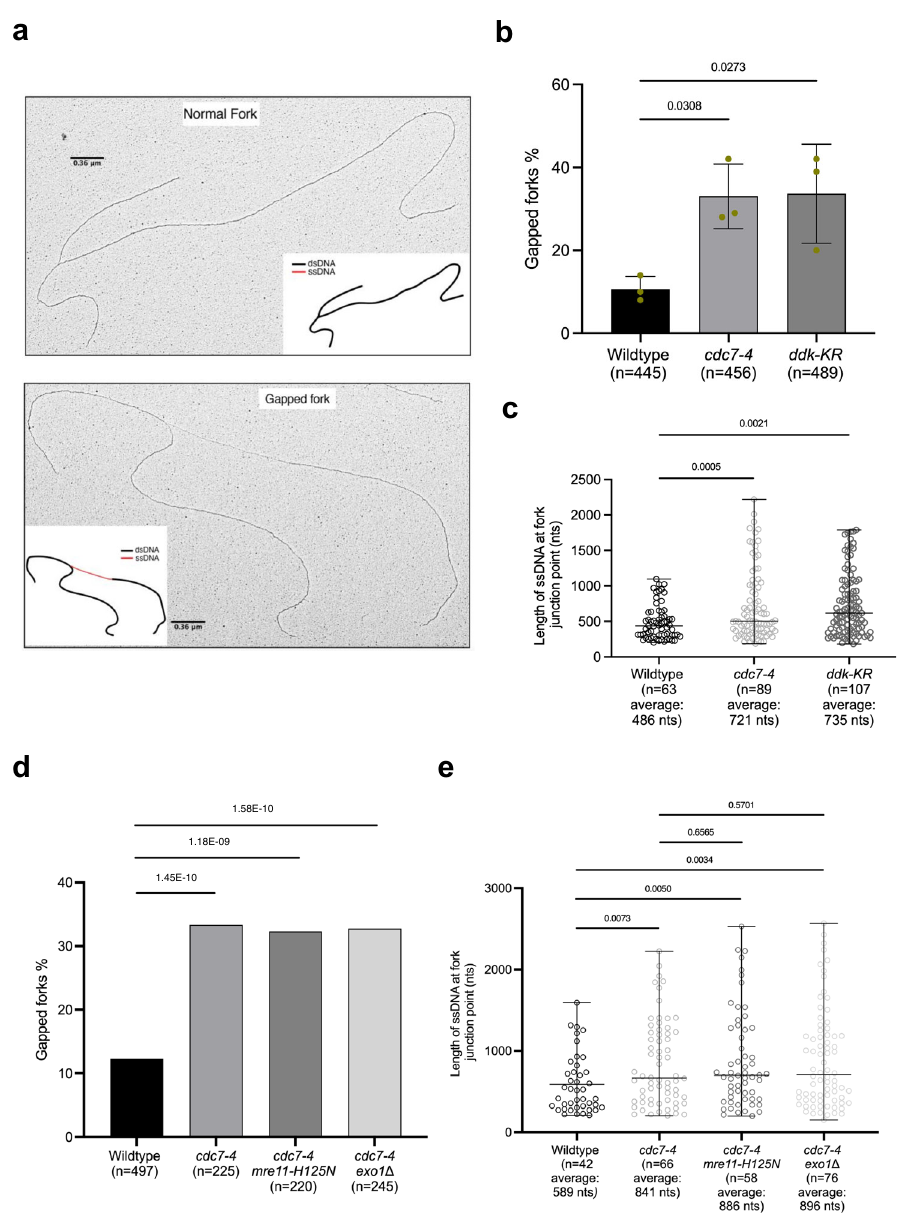
Fig. 3 SUMOylated DDK kinase prevents replication fork uncoupling. a Examples of normal and gapped forks visualized by Transmission electron microscopy (TEM) analysis along with schematic representations of DNA molecules with dsDNA (black) and ssDNA (red). Scale bars (black) of 360 nm calculated for dsDNA are reported. b TEM analysis of replication intermediates. Exponential cultures were arrested in G1 phase and released into S-phase in medium containing 0.033% MMS at 28 °C for 60 min. Histogram reports the percentages of gapped replication forks, from three independent experiments. The gapped forks category contains a small fraction of broken forks, derived from the mechanical breakage of the long ssDNA stretches present at the branching point of the gapped forks. The total number of replication intermediates scored in the three experiments is indicated as ‘ n ’ . Error bars represent standard deviation of three independent experiments, the center of the bar represents the average value. P -values were calculated by ordinary one-way ANOVA test. c Scatter dot plot representing the distribution of lengths of ssDNA stretches at the branching points of forks of indicated cells. Values are derived from the analysis of the samples presented in b . Central line in the plot indicates the average length of ssDNA discontinuity (in nucleotides), the bars represent distribution range. P values were calculated by unpaired two-tailed Student ’ s t test. d TEM analysis of the DNA replication intermediates formed in the same experimental conditions described in b in two independent experiments. ‘ n ’ represents the total number of DNA replication intermediates analyzed in the indicated sample. Histogram represents the percentage of gapped forks in the indicated cells as described in b . P values were calculated by Fischer ’ s exact two-sided test. e Scatter dot plot representing the distribution of the lengths of the ssDNA stretches (in nucleotides) at the fork branching points of the indicated yeast strains. ‘ n ’ is the total number of DNA replication intermediates analyzed. The middle line in the scatter dot plot indicates the average length of the ssDNA discontinuity (in nucleotides), bars show the distribution range. P -values were calculated by unpaired two-tailed Student ’ s t